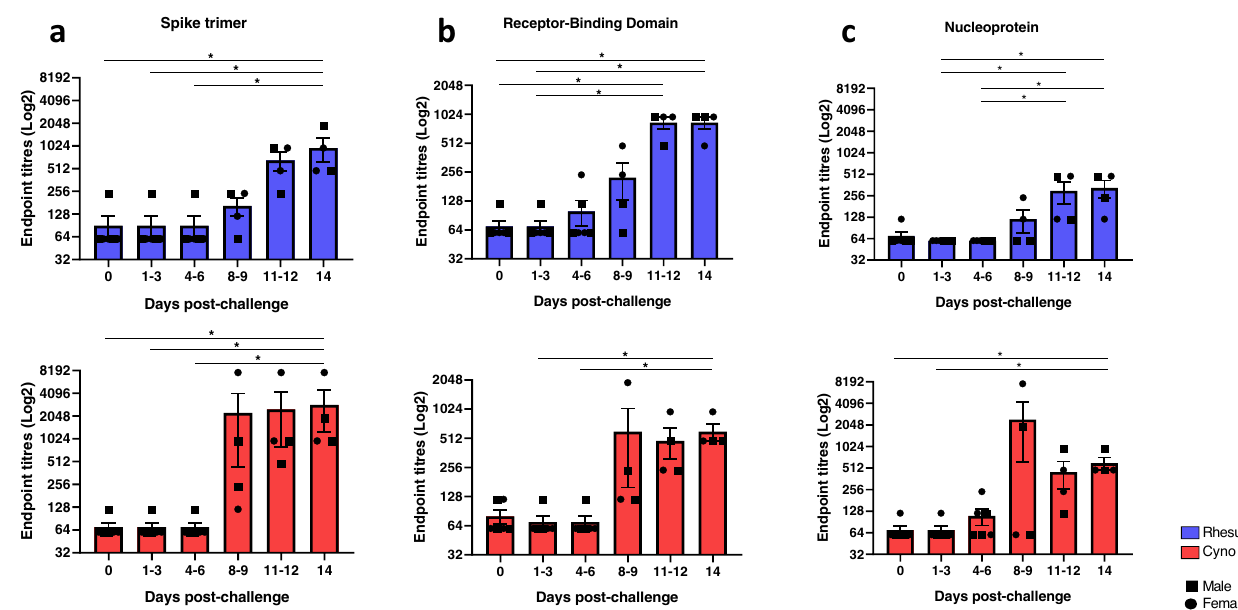
Fig. 8 SARS-CoV-2-speci fi c IgG antibodies measured by ELISA in naïve and SARS-CoV-2 infected macaques. Spike- ( a ), Receptor-Binding Domain- ( b ) and Nucleoprotein- ( c ) speci fi c IgG antibodies measured in sera of rhesus and cynomolgus macaques. Sera were collected from uninfected animals (day 0) or 1 – 3, 4 – 6, 8 – 9, 11 – 12 and 14 – 19 days following SARS-CoV-2 infection. n = 6 at 0, 1 – 3 and 4 – 6 dpc; n = 4 at 8 – 9, 11 – 12 and 14 dpc. Bars show the group mean±SEM with an endpoint titre determined for each individual animal shown as squares for males and dots for females. * p ≤ 0.05 (Kruskal – Wallis one- way ANOVA, two-sided). Experiment performed in